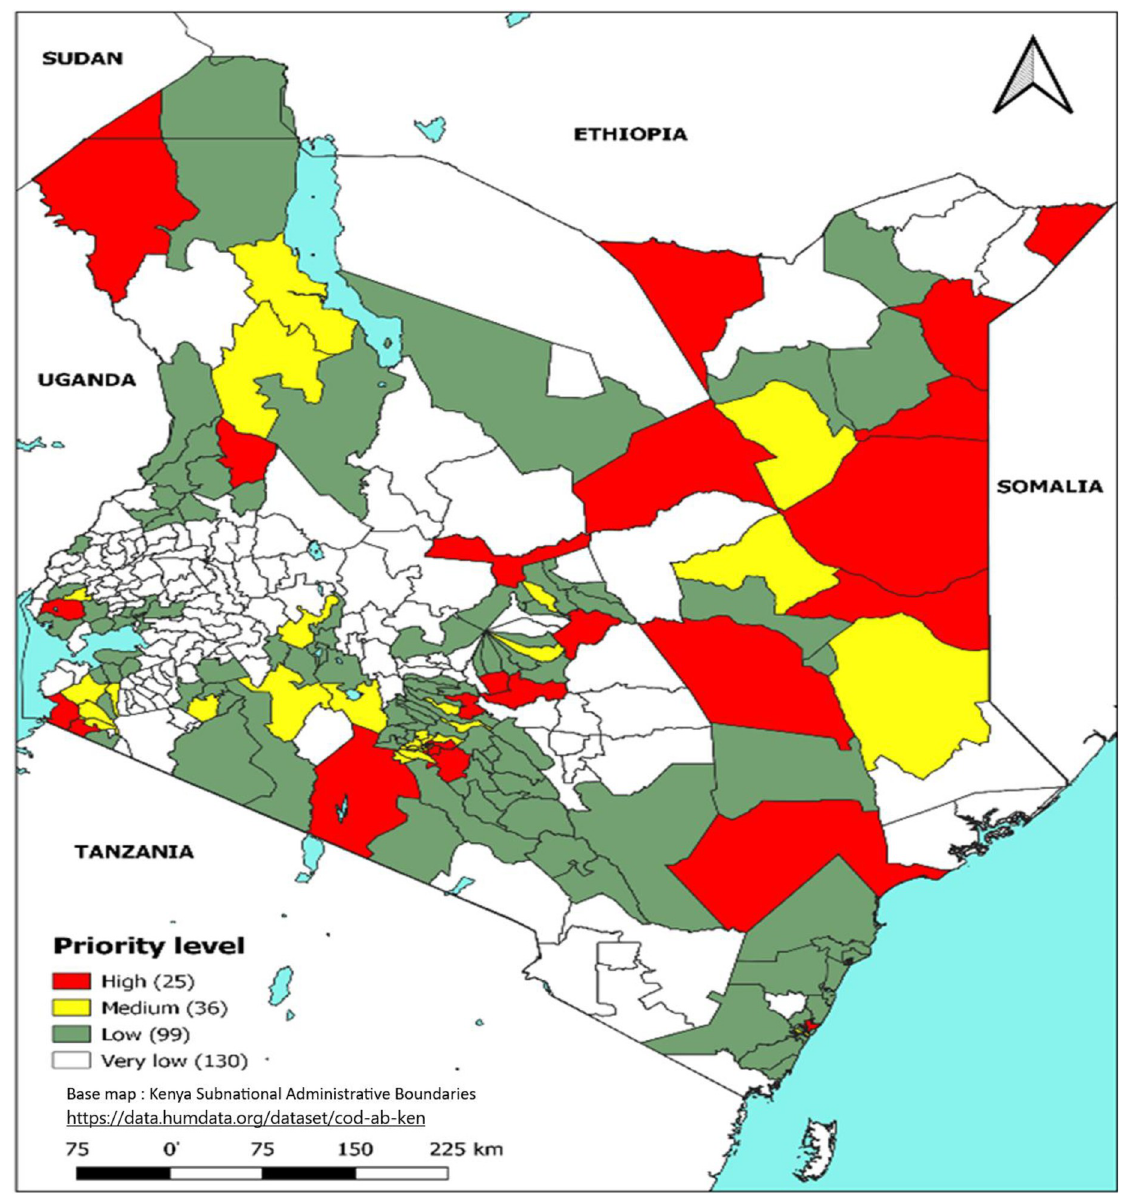
Fig 4. Priority sub-counties based on cholera MAI & Persistence, Kenya, 2015–2019. Link to base map layer: https://data.humdata.org/ dataset/cod-ab-ken Link to terms of use: https://data.humdata.org/faqs/licenses.